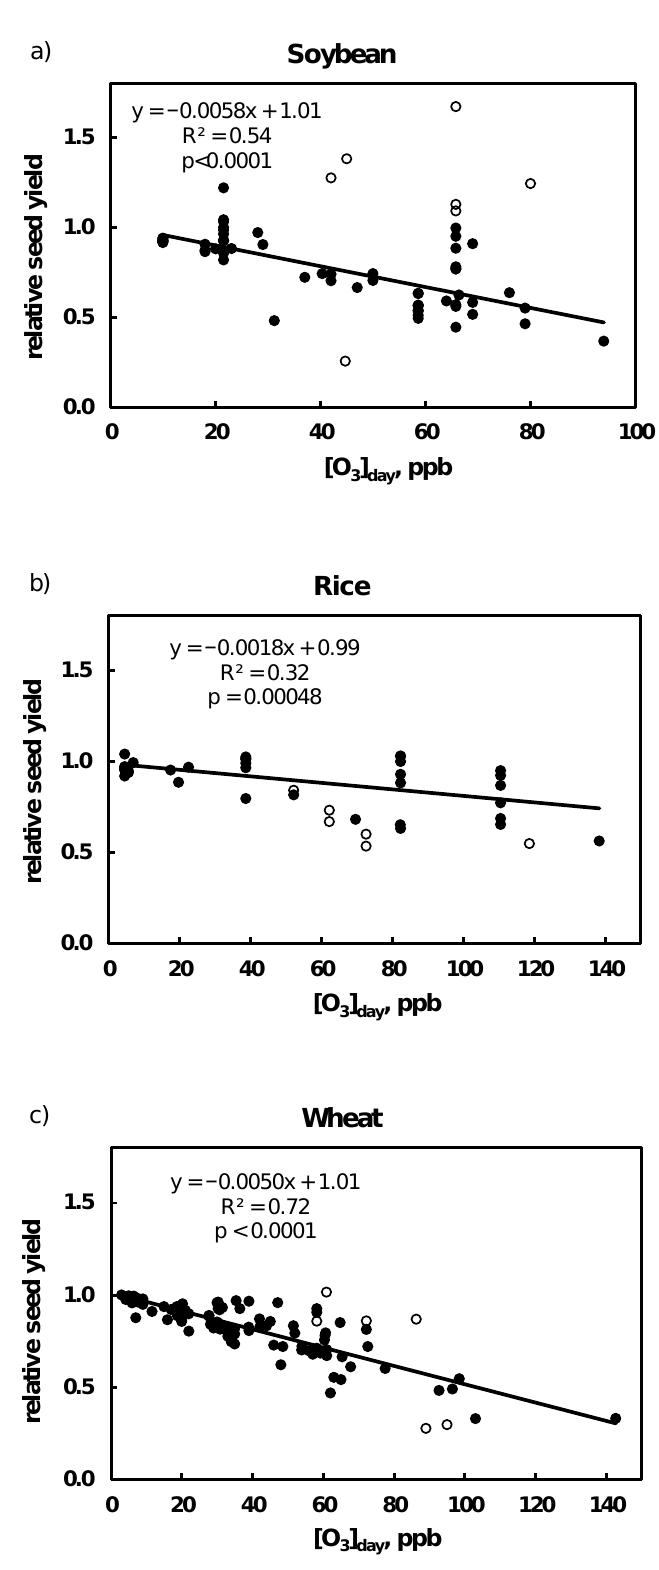
Figure 1. Relationship between relative seed yield (SY) and daytime O 3 concentration, [O 3 ] day , for ( a ) soybean; ( b ) rice; ( c ) wheat. Open circles denote data points representing statistical outliers for at least one of the studied response variables.